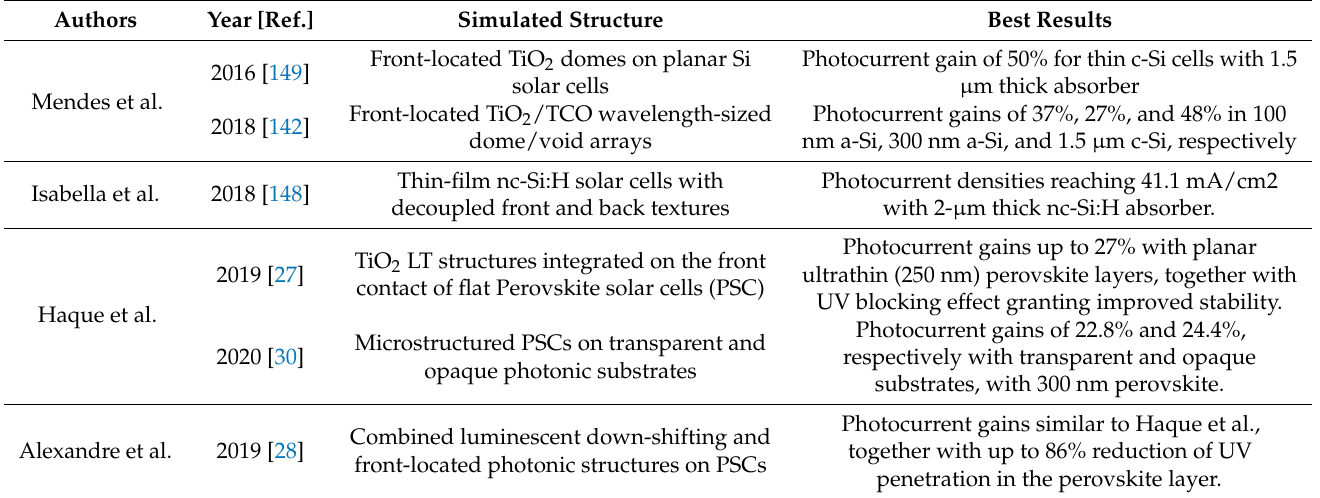
Table 1. Overview of simulation results on photonic microstructures for thin-film PV.